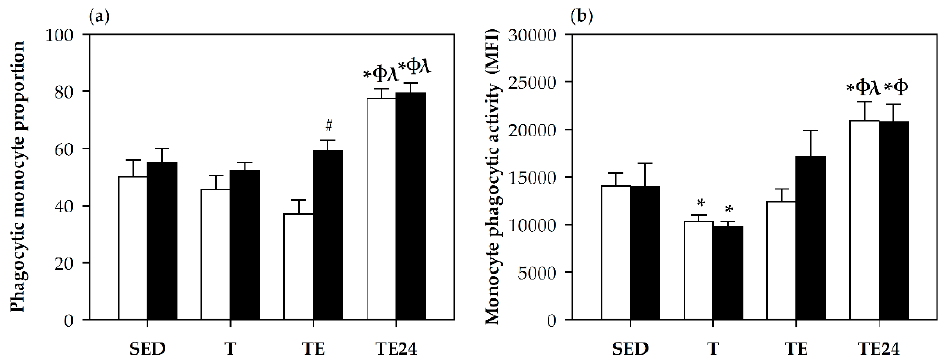
Figure 6. Phagocytic monocyte proportion ( a ) and monocyte phagocytic activity expressed as mean fluorescence intensity (MFI) ( b ). The non-supplemented groups are represented by white bars and the hesperidin-supplemented groups by black bars. SED = sedentary groups; T = trained groups; TE = T groups with an additional exhaustion test; TE24 = TE groups 24 h after the exhaustion test. Data are expressed as mean ± SEM ( n = 7–8). Statistical difference (Mann–Whitney U test): * p < 0.05 vs. SED group; φ p < 0.05 vs. T group; λ p < 0.05 vs. TE group; # significant differences between non-supplemented and the counterpart hesperidin-supplemented group ( p < 0.05). Table 3. Cytokine concentration (pg / mL) released by peritoneal macrophages stimulated by LPS. Peritoneal Macrophage Cytokine